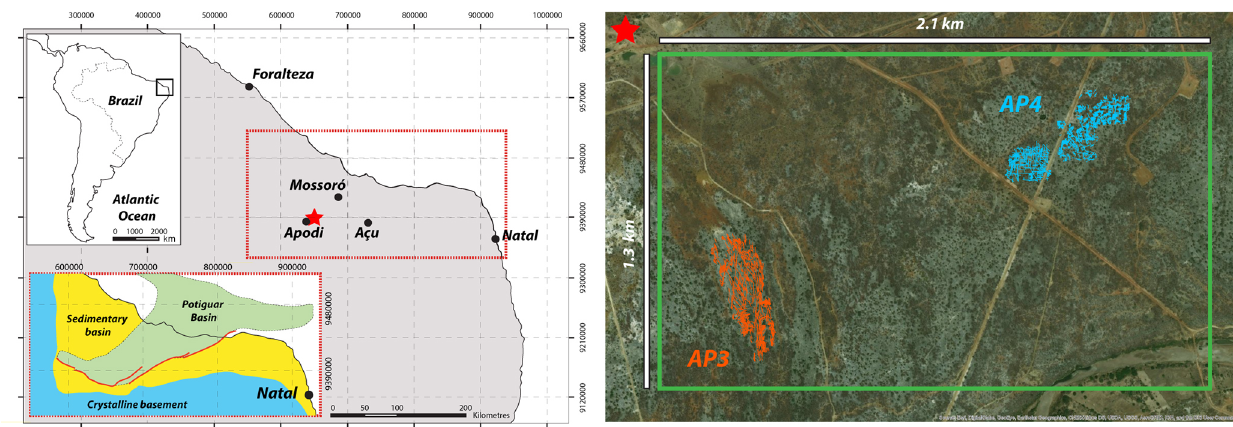
Figure 2. Locations of the area of interest and of the studied pavements near Apodi (red star).